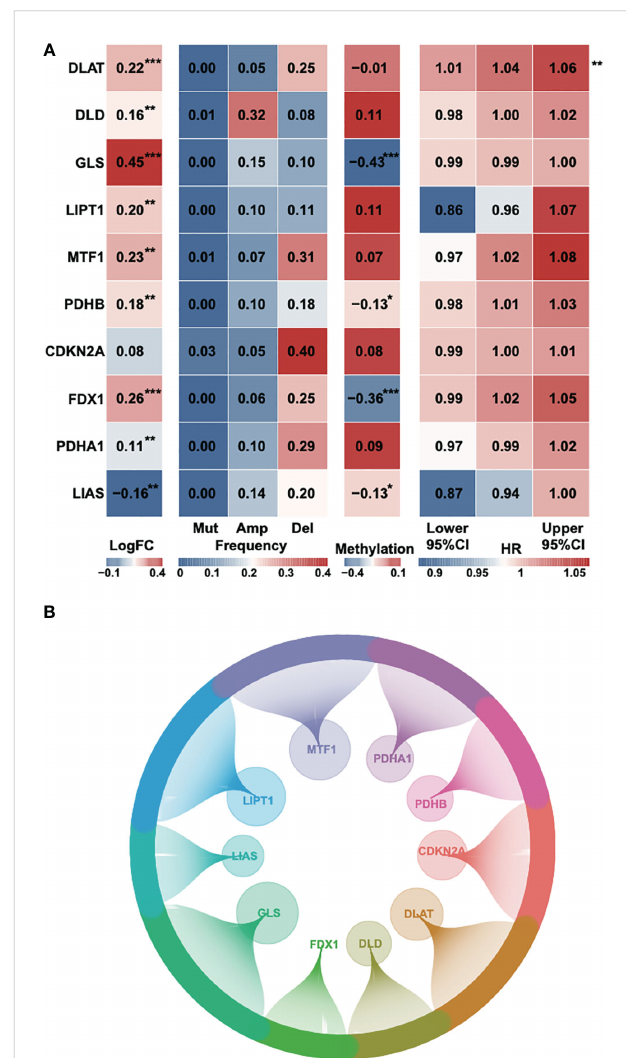
FIGURE 1 Identi fi cation of cuproptosis-related genes and corresponding lncRNAs. (A) The fold change, mutational frequency, methylation level and Hazard ratio of the ten cuproptosis-related genes. (B) The correlated lncRNAs of the ten cuproptosis-related genes. *P-value < 0.05, **P-value < 0.01, ***P-value <